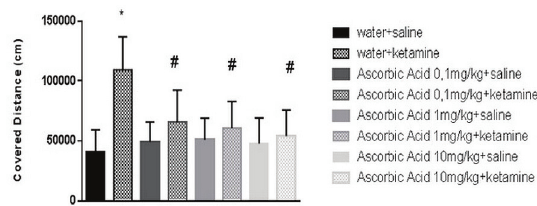
Figure 1 - Locomotor activity. The effects of supplementation with AA (0.1, 1 and 10 mg/kg, p.o) on locomotor activity in an animal model of SZ induced by Ket (25 mg/kg, i.p). Data are expressed as mean ±SEM (N=10-12); * p<0.05 difference from Water+Sal (control group); # p<0.05 difference from Water+Ket group.